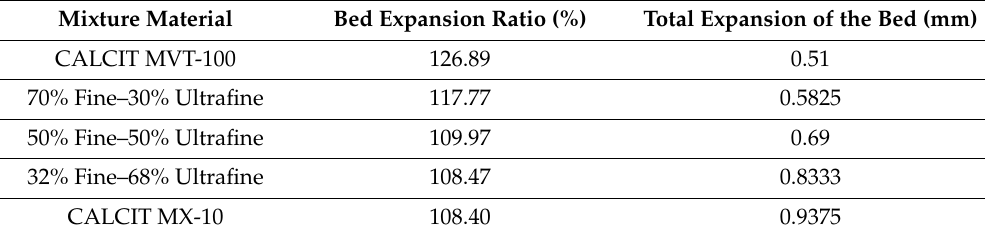
Table 4. The bed expansion ratio (%) and the total bed expansion of the used powder